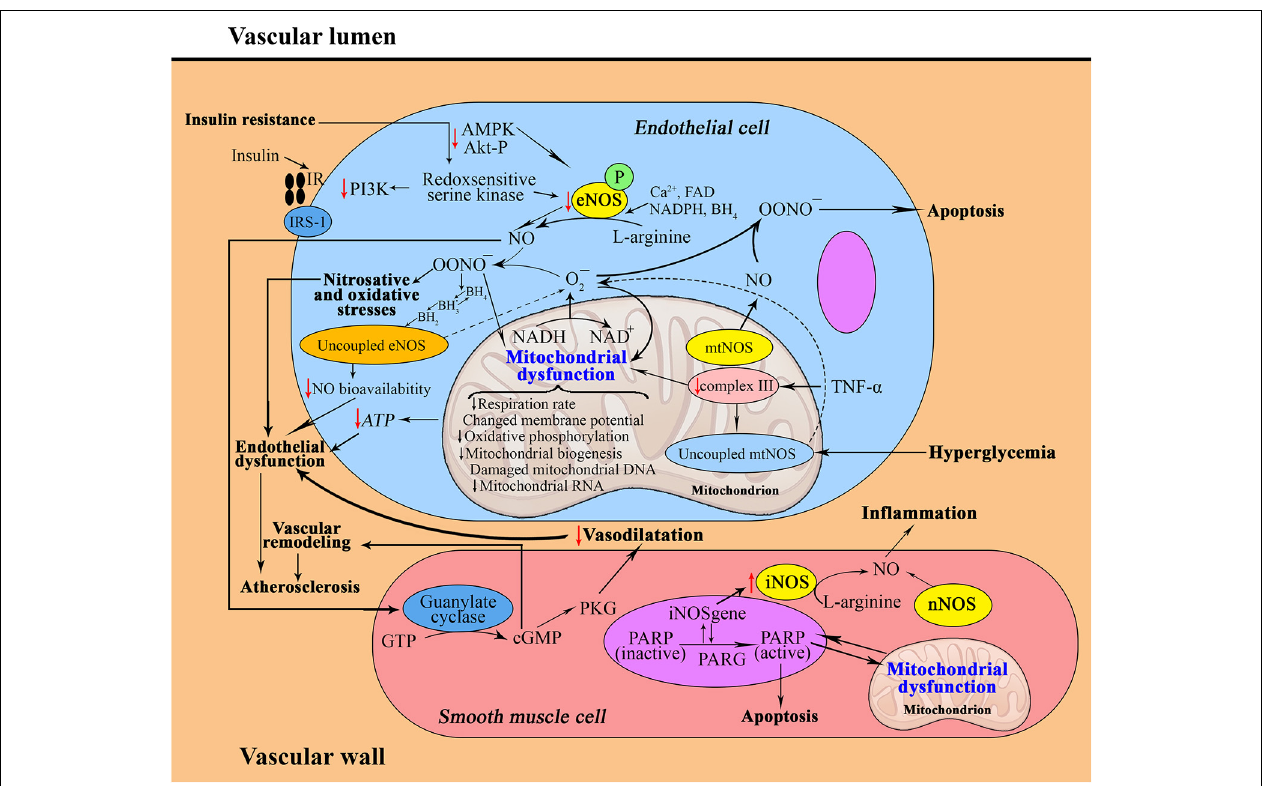
FIGURE 1 | Interrelation between nitric oxide and mitochondria in the pathophysiology of metabolic syndrome (a, in the vascular wall; b, in an adipocyte; c, in a hepatocyte). a: Insulin resistance contributes to decreased activities of signaling molecules, which leads to decreased eNOS activity. Superoxide generated in mitochondria can modestly, and peroxynitrite can strongly, oxidize BH4–BH2, leading to uncoupling of eNOS, increased production of ROS and endothelial dysfunction. Moreover, mtNOS becomes “uncoupled”; it switches from a NO-generating enzyme to a superoxide-producing enzyme. Increased production of peroxynitrite and